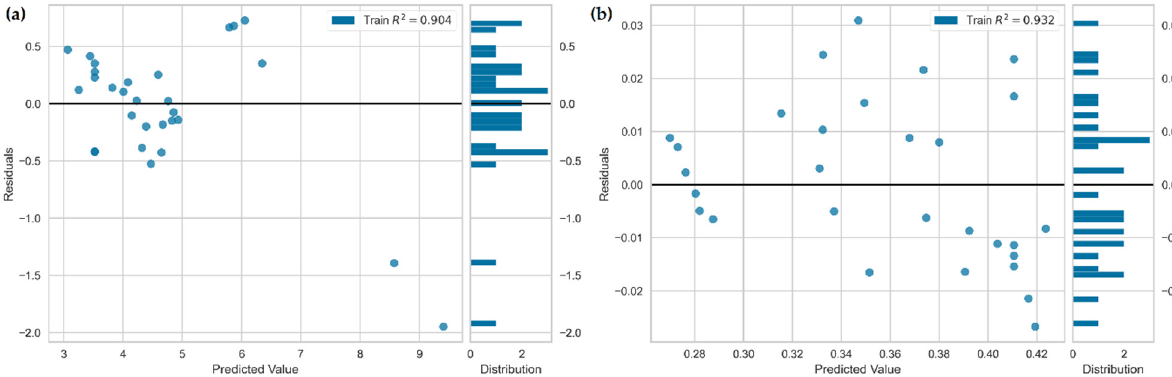
Figure 10. Residuals versus random forest regression predicted ( a ) MRR ( b ) Kerf.